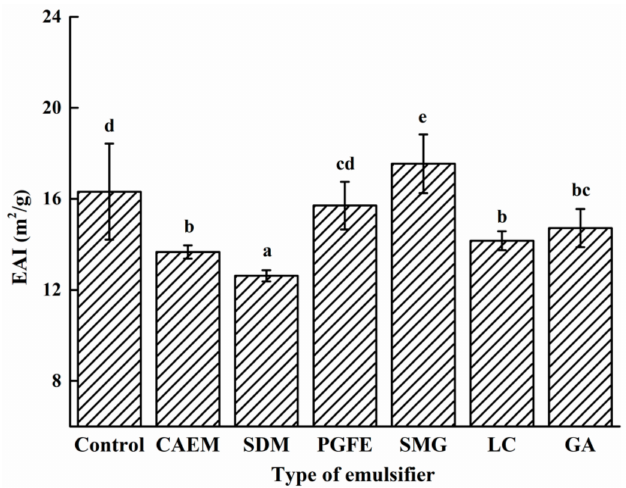
Figure 2. E ff ect of di ff erent emulsifiers on the emulsification activity index of the